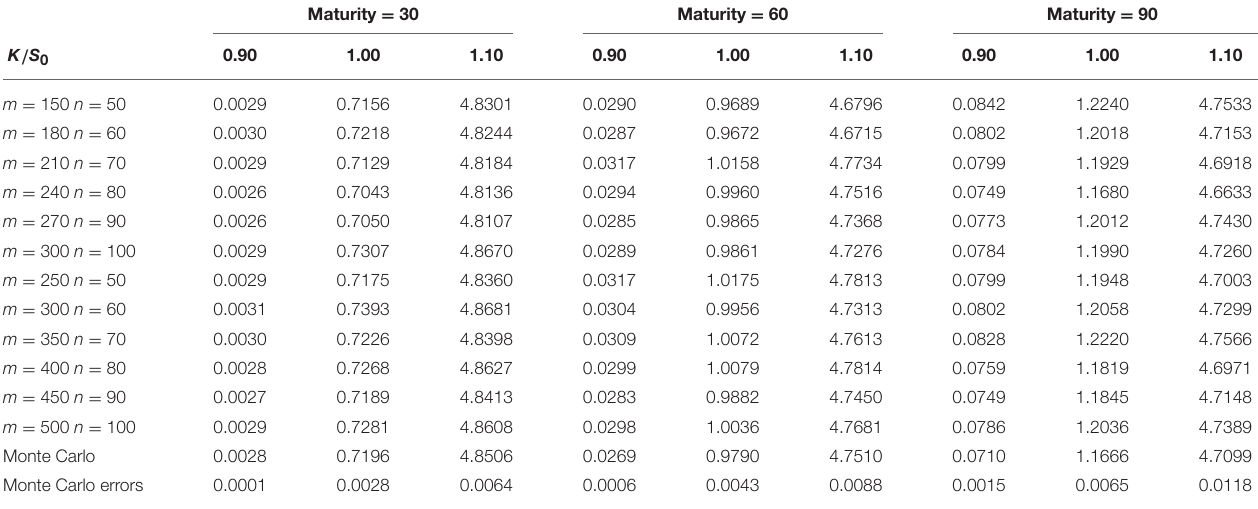
TABLE 2 | European put options in the CTS-GARCH